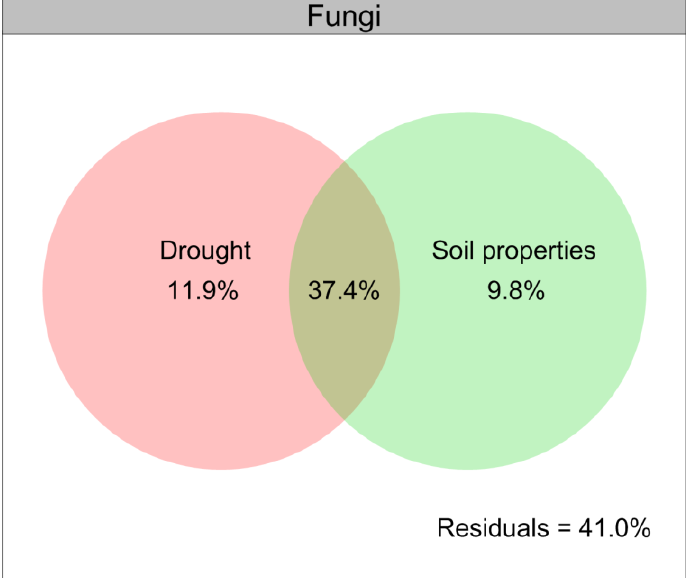
Figure 9. Variation partitioning analysis (VPA) of the relative contributions of drought and soil properties to variation of fungal community. Soil properties indicated include soil organic carbon, total nitrogen, total phosphorus, available phosphorus, ammonium nitrogen, nitrate nitrogen and pH.